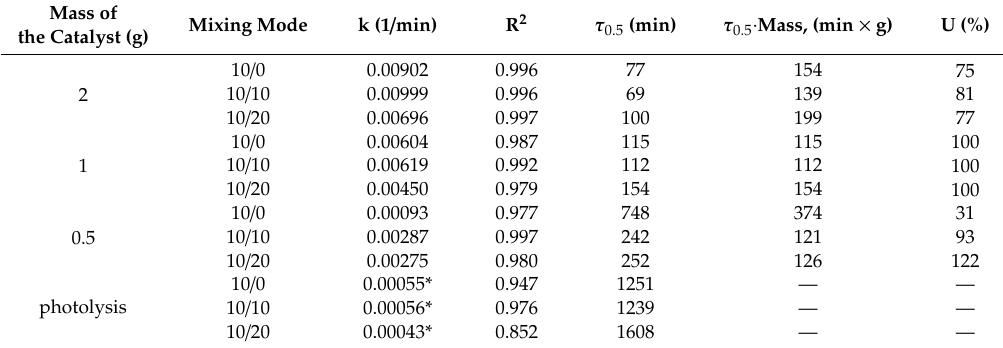
Table 1. Summary of the photocatalytic experiments using a periodic air-sparged